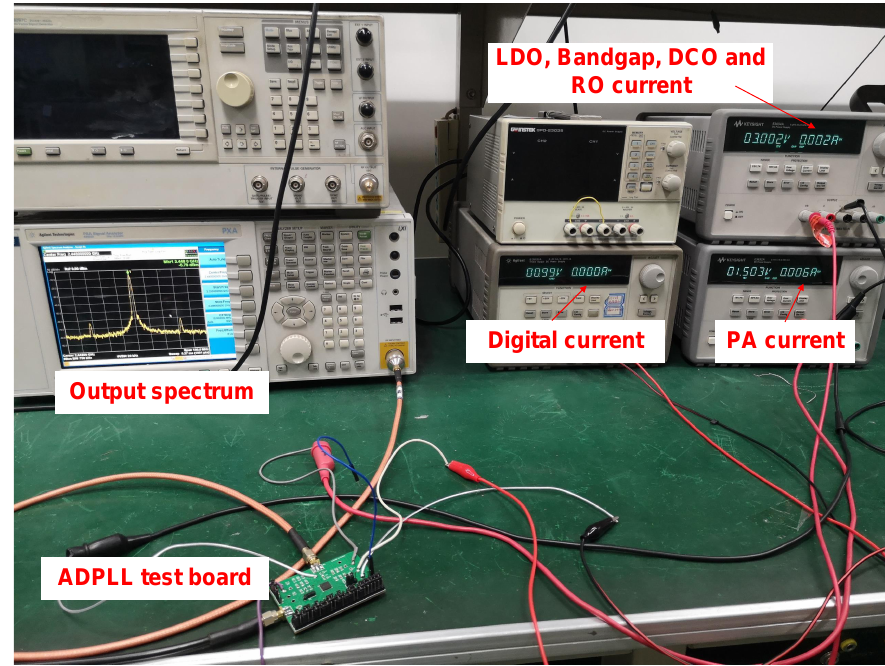
Figure 22. ADPLL test